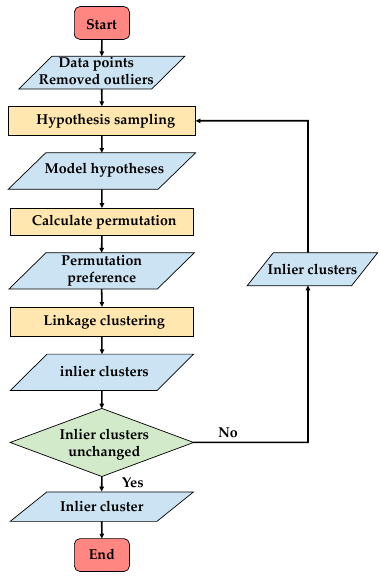
Figure 6. The flowchart of inlier segmentation.